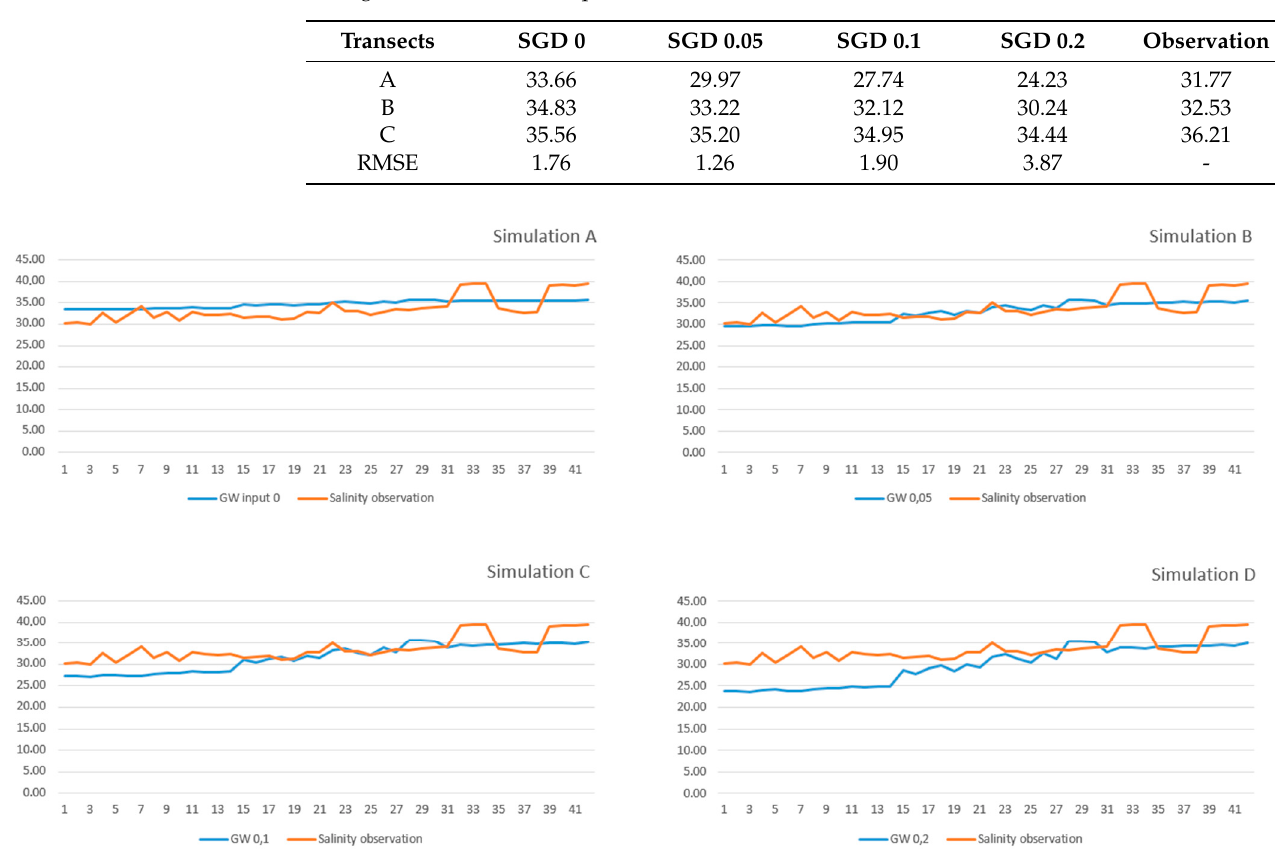
Table 2. Modeled salinity with different estimated SGD inputs and observed in the three transects of the lagoon and root mean square error RMSE for each.